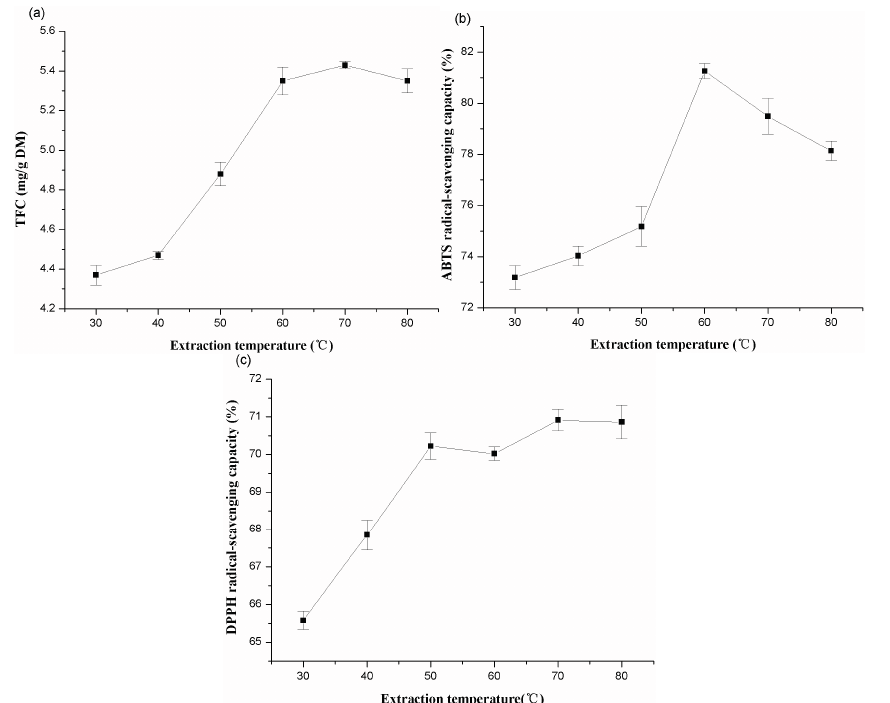
Figure 2. Effects of extraction temperature on the extraction yield of total flavonoids ( a ); ABTS ( b ) and DPPH ( c ) radical-scavenging capacities of extracts from